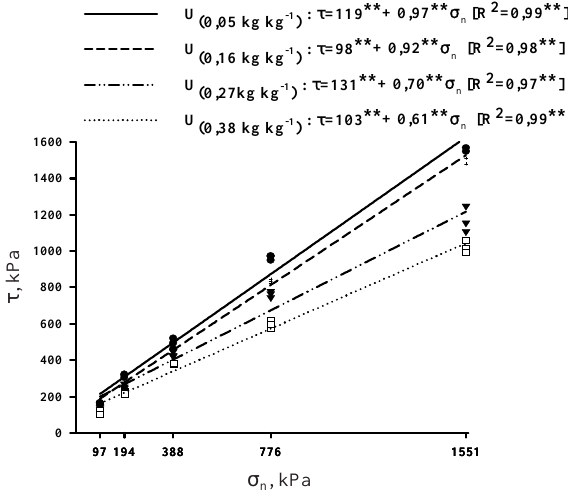
Figura 3. Relação linear simples entre a tensão normal ( σσσσσ ) e tensão cisalhante ( τττττ ) do Latossolo n Vermelho distrófico, sob cerradão (CE), submetido a diferentes teores de